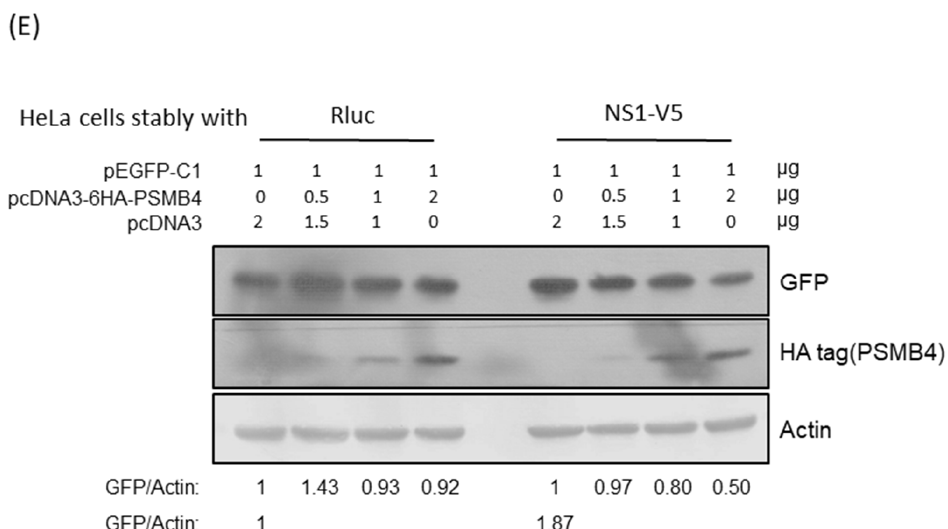
Figure 6. ( A ) PSMB4 overcame the inhibition of IFN activity by NS1. Cells were transfected with empty vector, expression plasmids for NS1, PSMB4 or both, as indicated. Poly I/C was added 2 h after transfection. Luciferase activities were analyzed 24 h after transfection. ( B , C ) PSMB4 did not modulate luciferase expression ( B ), while it suppressed the enhancement in luciferase expression caused by transiently expressed NS1. Luciferase activities were analyzed 48 h after cells were transfected with different combinations of plasmids as indicated. ( D ) PSMB4 suppressed the enhancement in GFP expression caused by transiently expressed NS1. Cell lysates from A549 cells transfected with different combinations of plasmids as indicated were analyzed by SDS-PAGE and Western blotting against GFP, V5 (for exogenous NS1), HA tag (for exogenous PSMB4), PSMB4 or actin. ( E ) PSMB4 suppressed the enhancement in GFP expression caused by stably expressed NS1. Cell lysates from HeLa cells stably expressing luciferase or NS1 protein transfected with different combinations of plasmids as indicated were analyzed by SDS-PAGE and Western blotting against GFP, HA tag (for exogenous PSMB4) or actin. *** p <